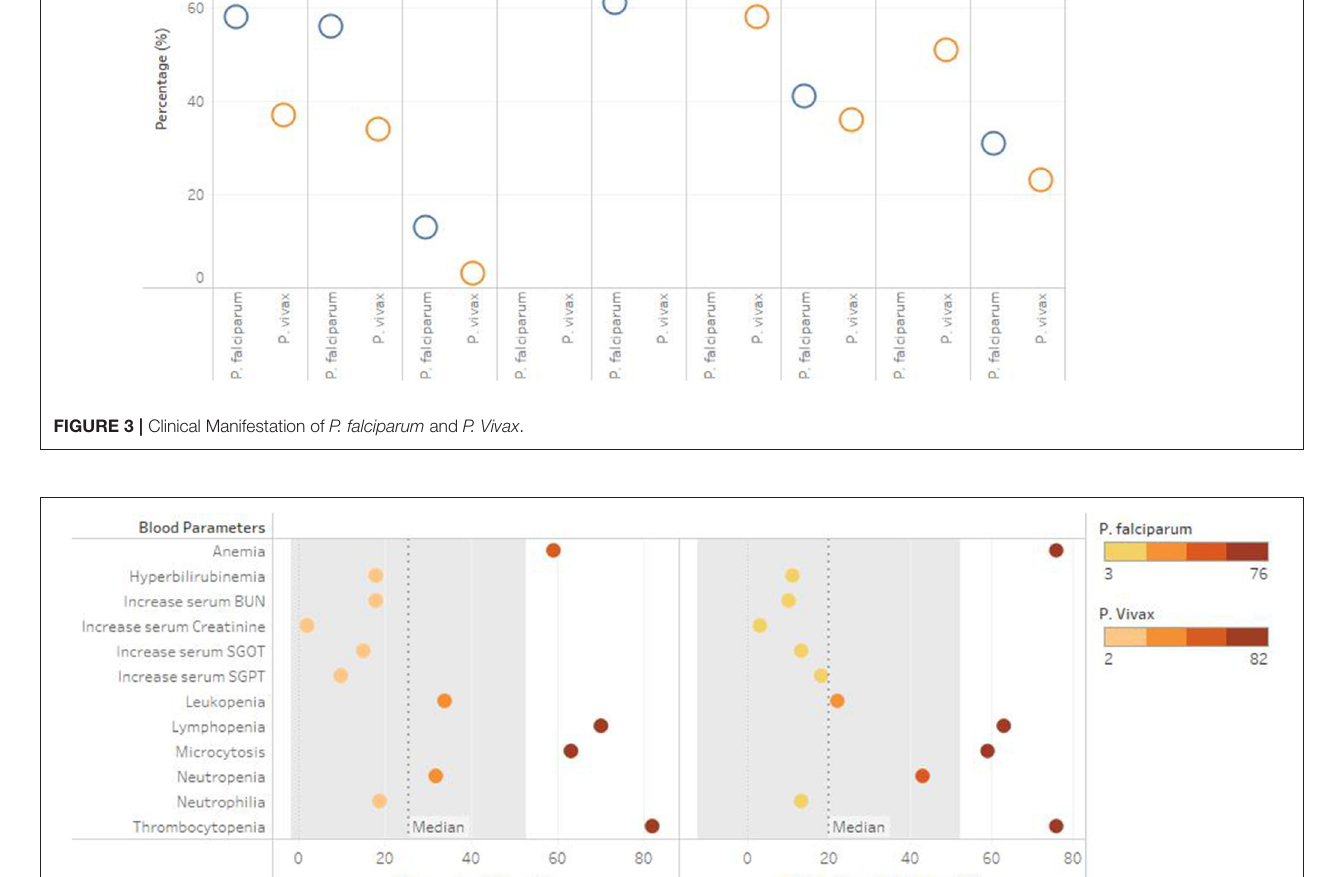
( Table 5 ). The total treatment used for malaria infection in Bannu district was Artemisinin Combination